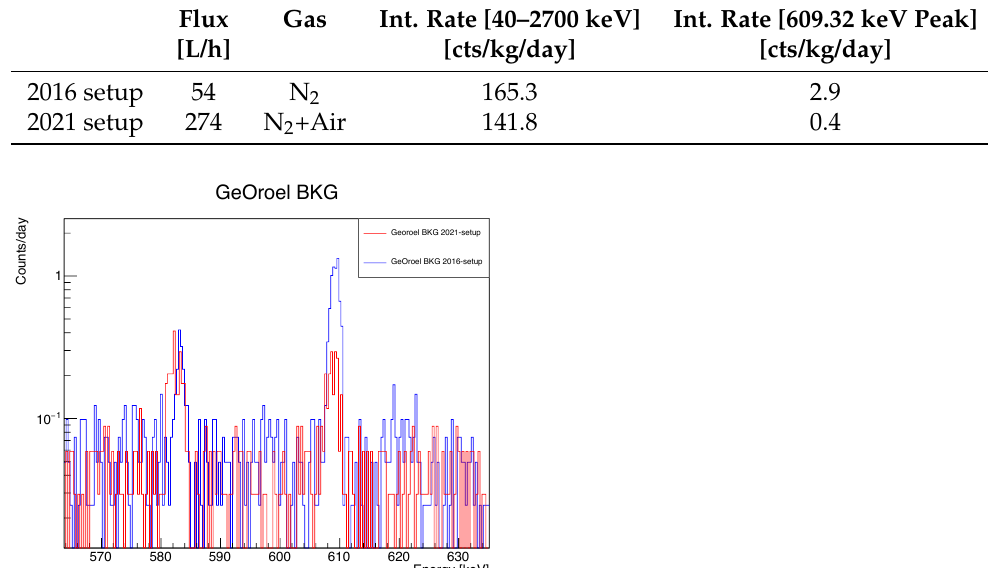
Table 4. Background counts in the 2 setups: 2016-setup with a flux of N 2 from dewar evaporation of 54 L/h; 2021-setup with a flux of 274 L/h made by combined N 2 from dewar evaporation and ATEKO-Air.